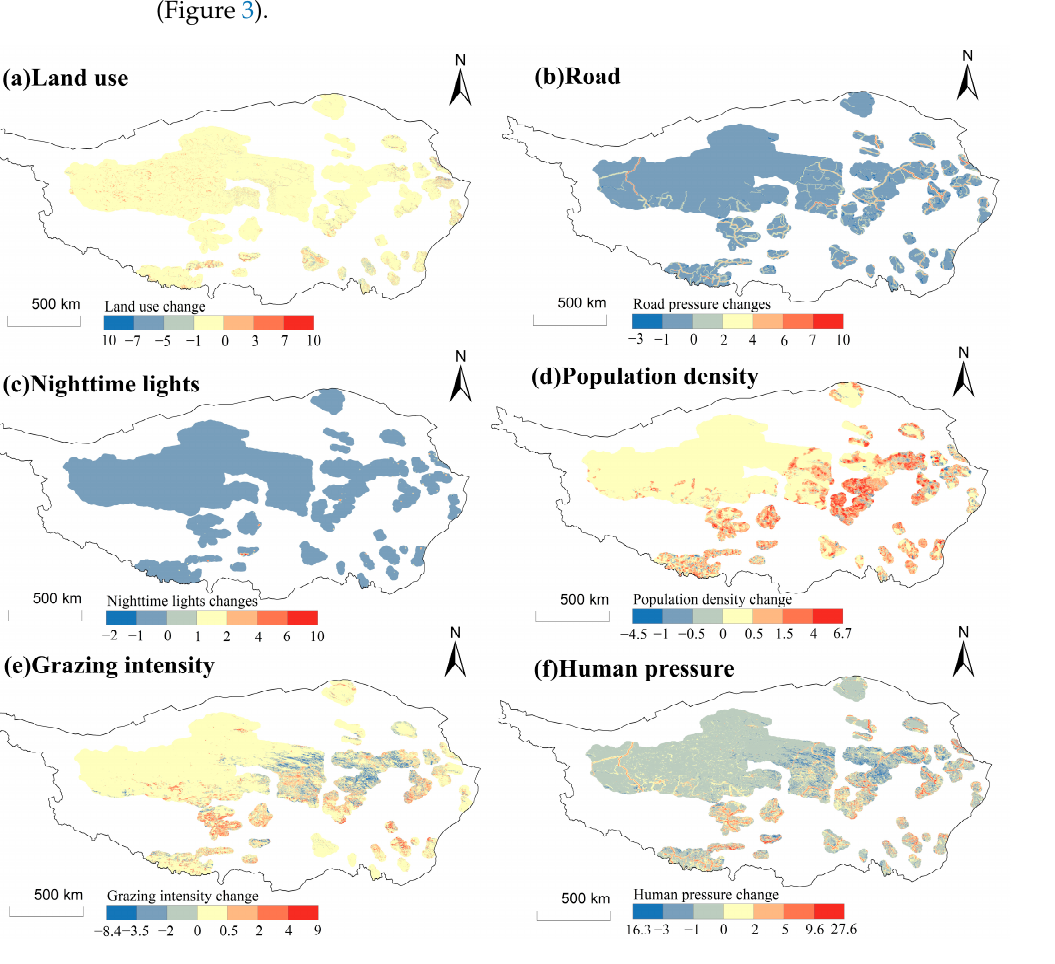
Figure 3. Spatiotemporal changes in fi ve HPs in the NRs of the Qinghai–Tibet Plateau for 2000–2020.